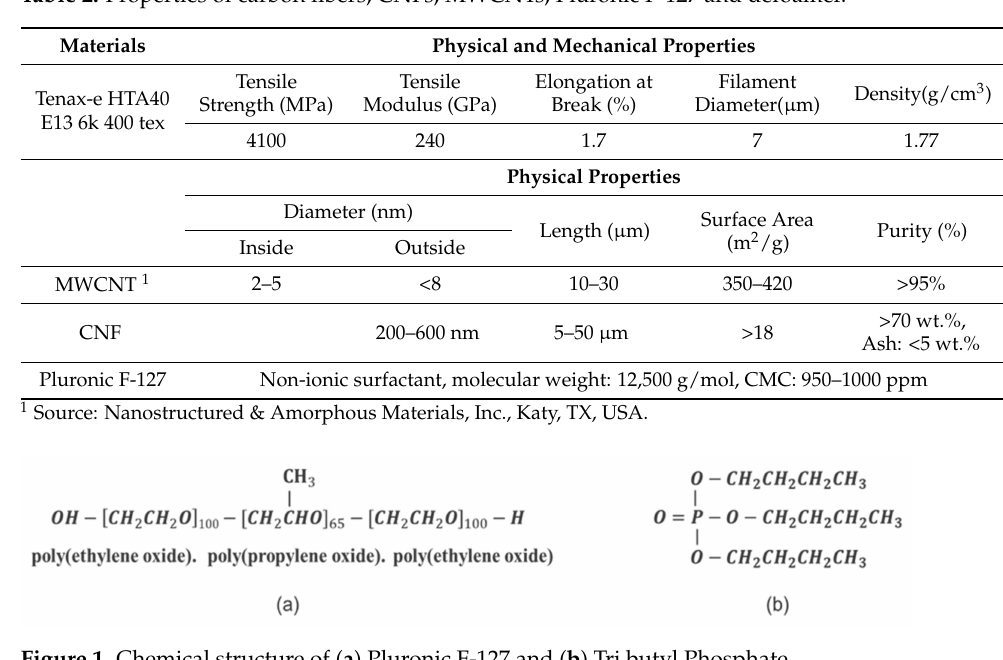
Figure 1. Chemical structure of ( a ) Pluronic F-127 and ( b ) Tri butyl